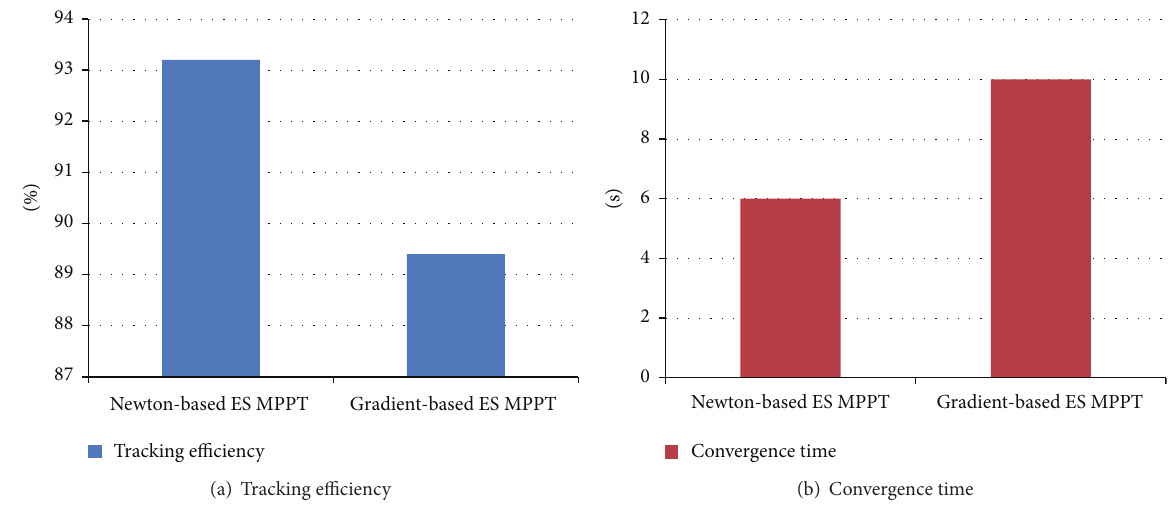
Figure 17: The numerical comparison between the proposed MPPT algorithm and classical extremum seeking MPPT algorithm under irradiance 800 W/m 2